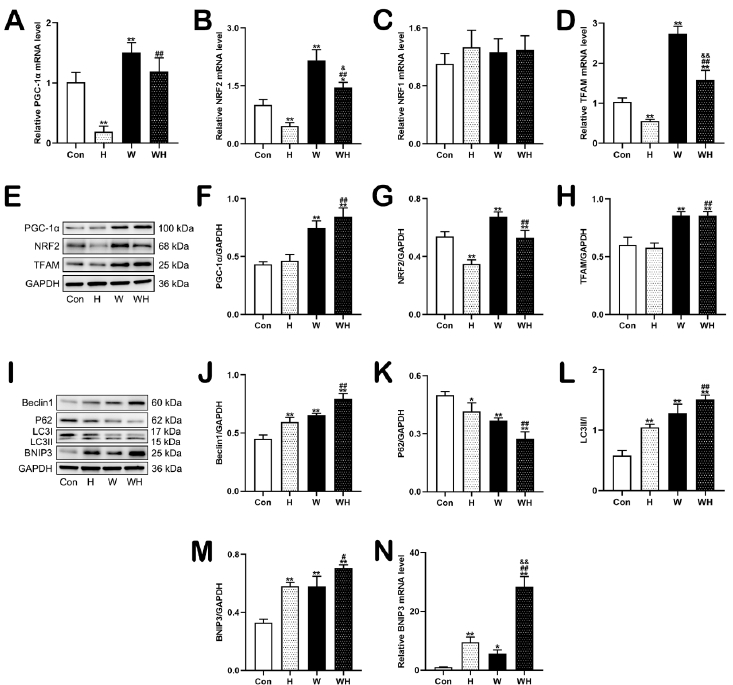
Figure 5. WA enhanced mitochondrial biogenesis and BNIP3-mediated mitophagy in cardiomyocytes. ( A – D ) Relative mRNA expression of PGC-1 α ( A ), NRF2 ( B ), NRF1 ( C ), and TFAM ( D ). ( E ) Representative immunoblots of proteins involved in mitochondrial biogenesis. ( F – H ) Quantification of mitochondrial biogenesis-related protein (PGC-1 α , NRF2, and TFAM) expression in cardiomyocytes. ( I ) Representative immunoblots of autophagy-related proteins (Beclin1, P62, LC3) and a mitophagy-related protein (BNIP3) in cardiomyocytes. ( J – M ) Statistical graphs showing relative expression of the indicated proteins. ( N ) Relative mRNA level of BNIP3 in cardiomyocytes. The values are presented as the mean ± SEM of three independent experiments ( n = 3). * p < 0.05 or ** p < 0.01 vs. the Con group. # p < 0.05 or ## p < 0.01 vs. the H group. & p < 0.05 or && p < 0.01 vs. the W group.